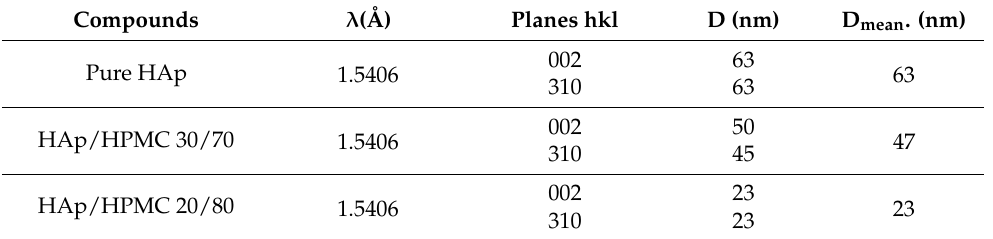
Table 1. Average size of apatitic nanoparticles according to Scherrer’s formula. Compounds λ (Å)